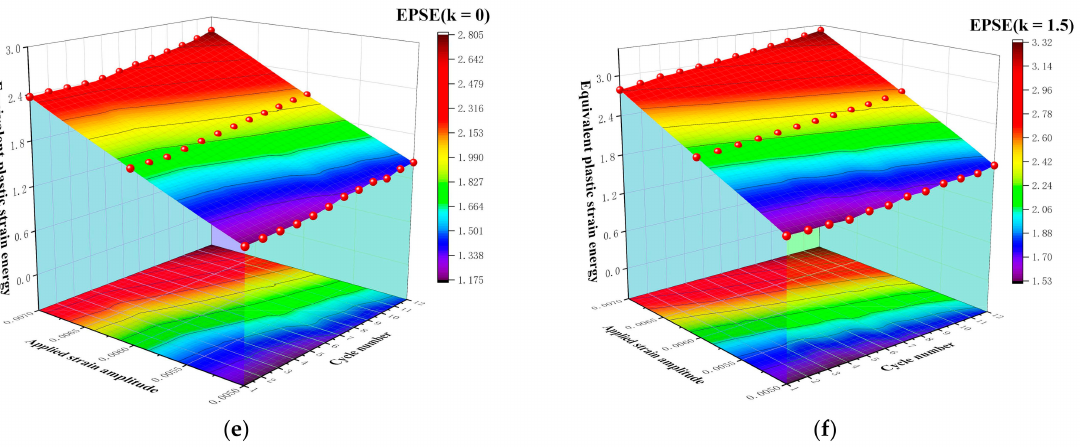
Figure 6. Simulated energy dissipation results and the location of maximum value under the strain amplitude of 0.007: ( a ) k = 0 and ( b ) k = 1.5; ( c ) Contours of stress triaxiality at the tension peak of 6th cycle; ( d ) Cyclic hysteresis loop for the k = 1.5 and k = 0 at the maximum fatigue damage location in terms of the 1st cycle, respectively; PSE response surface for ( e ) k = 0 and ( f ) k = 1.5.